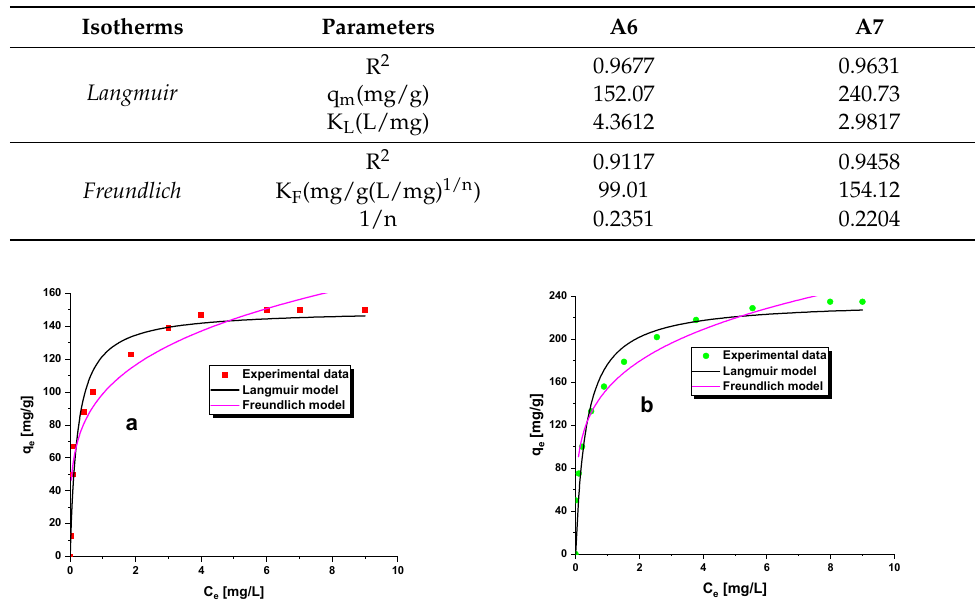
Figure 8. Non-linear fitting of isotherm models: Langmuir isotherm ( a ) and Freundlich isotherm ( b ).